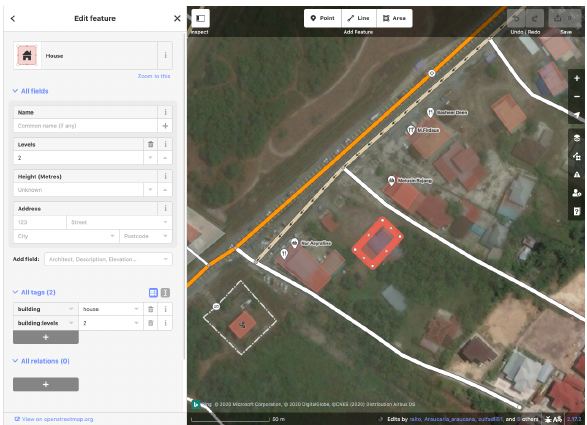
Figure 1. Example of editing the geometry and attributes (e.g. levels) in OpenStreetMap for a building in Telisai, Brunei.